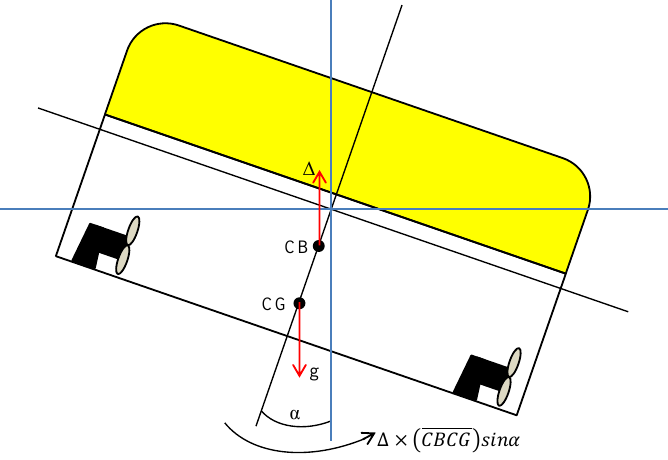
Figure 2. Righting moment of stable ROV. The righting moment is a function of the buoyancy force, distance between centre of buoyancy (CB) and centre of gravity (CG), angle from upright position and gravity.